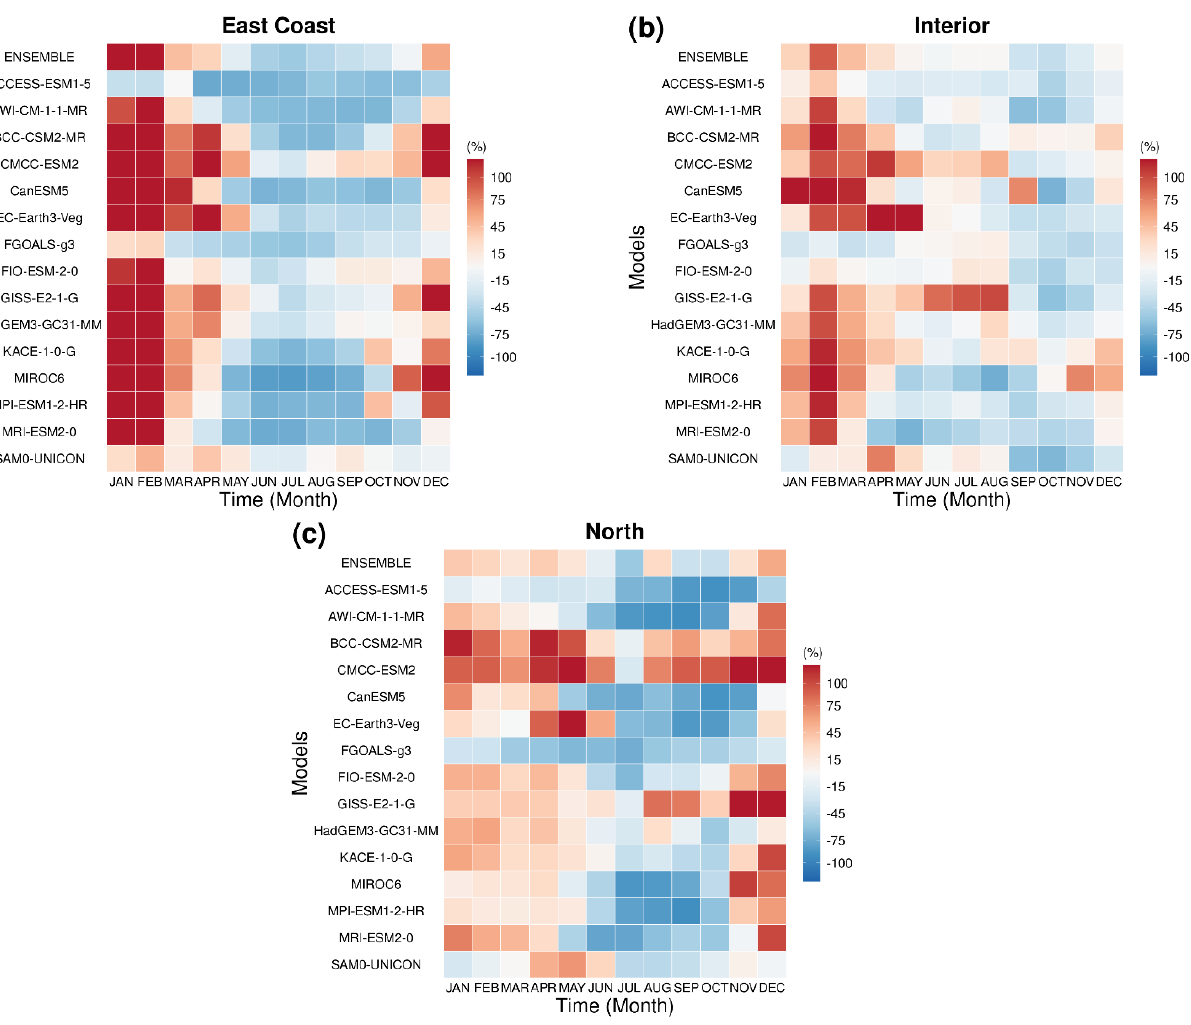
Figure 4. Annual cycle of average precipitation over subregions ( a ) East Coast, ( b ) Interior, and ( c ) North of NEB, based on the reference period (1980–2014).